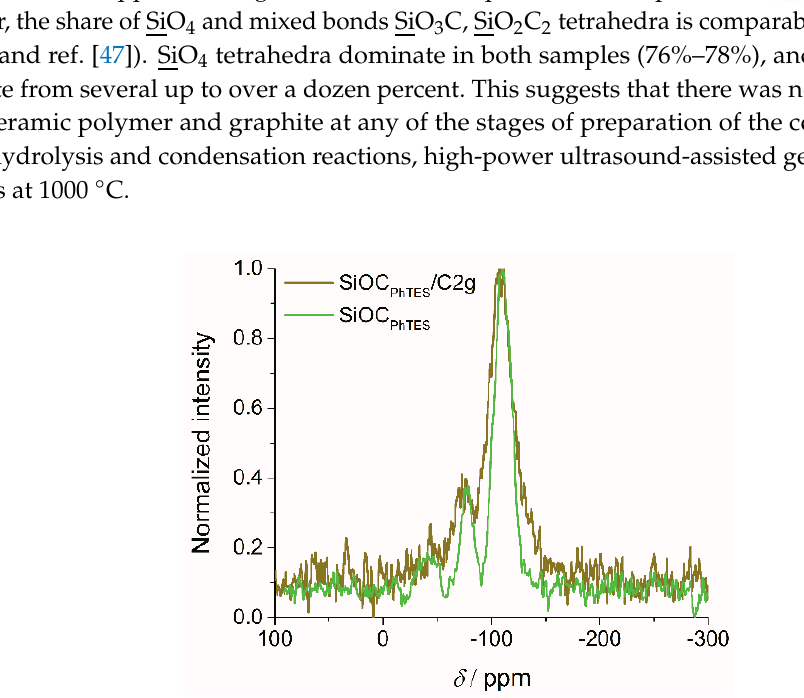
Table 2. Data obtained from fitting of 29 Si MAS-NMR spectra of the pure ceramic and the composite samples.